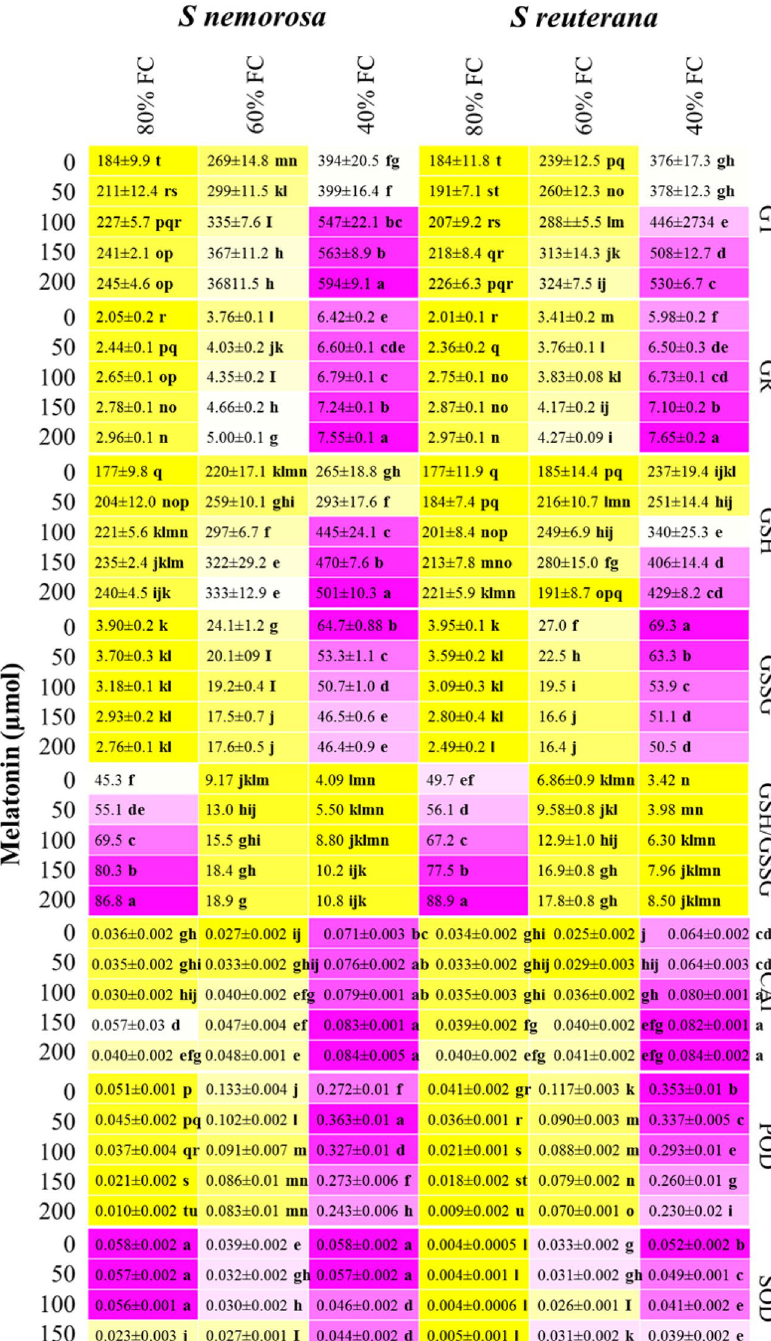
Figure 3. Heatmap representation of the interactive effects of drought stress and melatonin application on total glutathione (GT), glutathione reductase (GR), reduced glutathione (GSH), oxidized glutathione (GSSG), GSH/GSSG, catalase (CAT) activity ( µ mole min − 1 mg protein), peroxidase (POD) activity ( µ mole min − 1 mg protein), and superoxide dismutase (SOD) activity ( µ mole min − 1 mg protein) of Salvia nemorosa L., and Salvia reuterana Boiss. Three-way ANOVA test: Means followed by the same letter are not significantly different by the LSD Multiple Range test at P ≤ 0.05. Purple and yellow represent increased and decreased values,